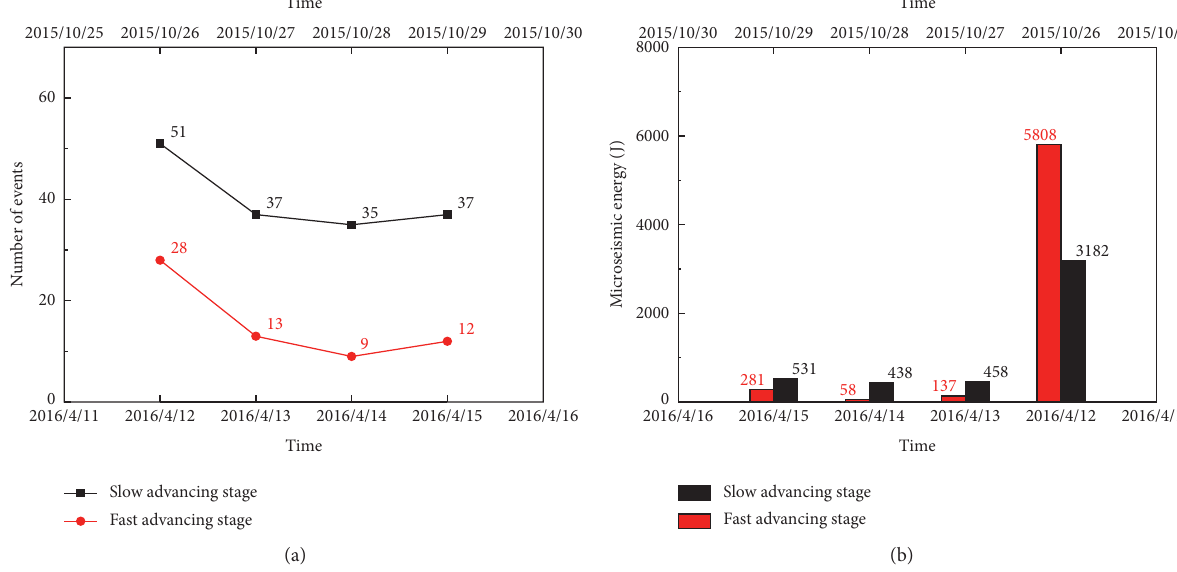
Figure 4: Variation of microseismic events and released energy under different mining speeds. (a) Variation of microseismic events under different mining speeds. (b) Variation of energy released by the microseisms under different mining